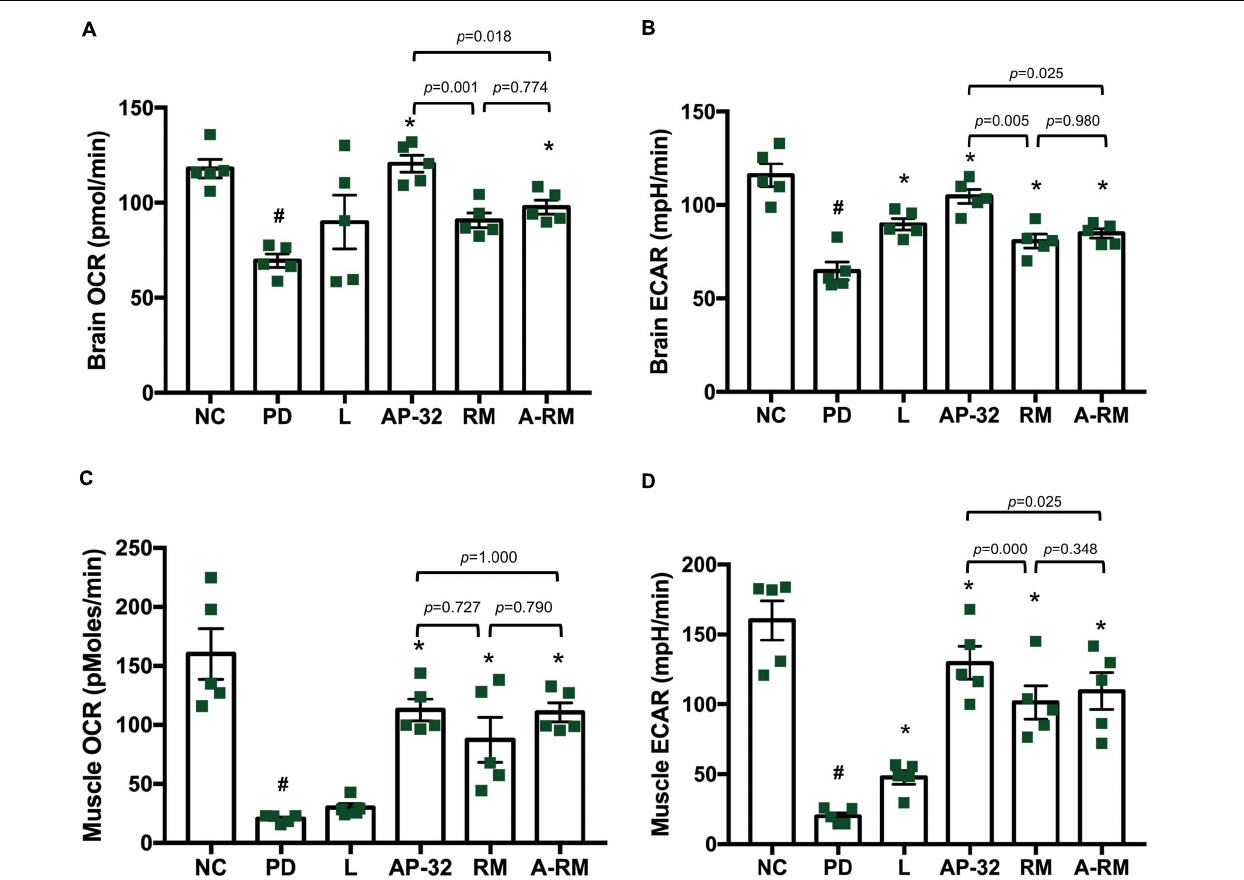
FIGURE 4 | The effect of AP-32, RM, and A-RM on mitochondrial function in the brain and soleus muscle after 8-weeks of supplementation. Mitochondrial function was evaluated by basal mitochondria respiration, oxygen consumption rate (OCR), and basal glycolysis rate, and basal extracellular acidification flux (ECAR). (A,B) The mitochondrial activates in the brain, including striatum and SNc. (C,D) The mitochondrial actives in the soleus muscle. All data are expressed as mean ± SEM ( n = 5 rats/group). # p < 0.05 PD group compared to NC group. * p < 0.05 L, AP-32, RM, and A-RM groups compared to PD group. Data were evaluated by one-way ANOVA with Tukey’s post hoc test.